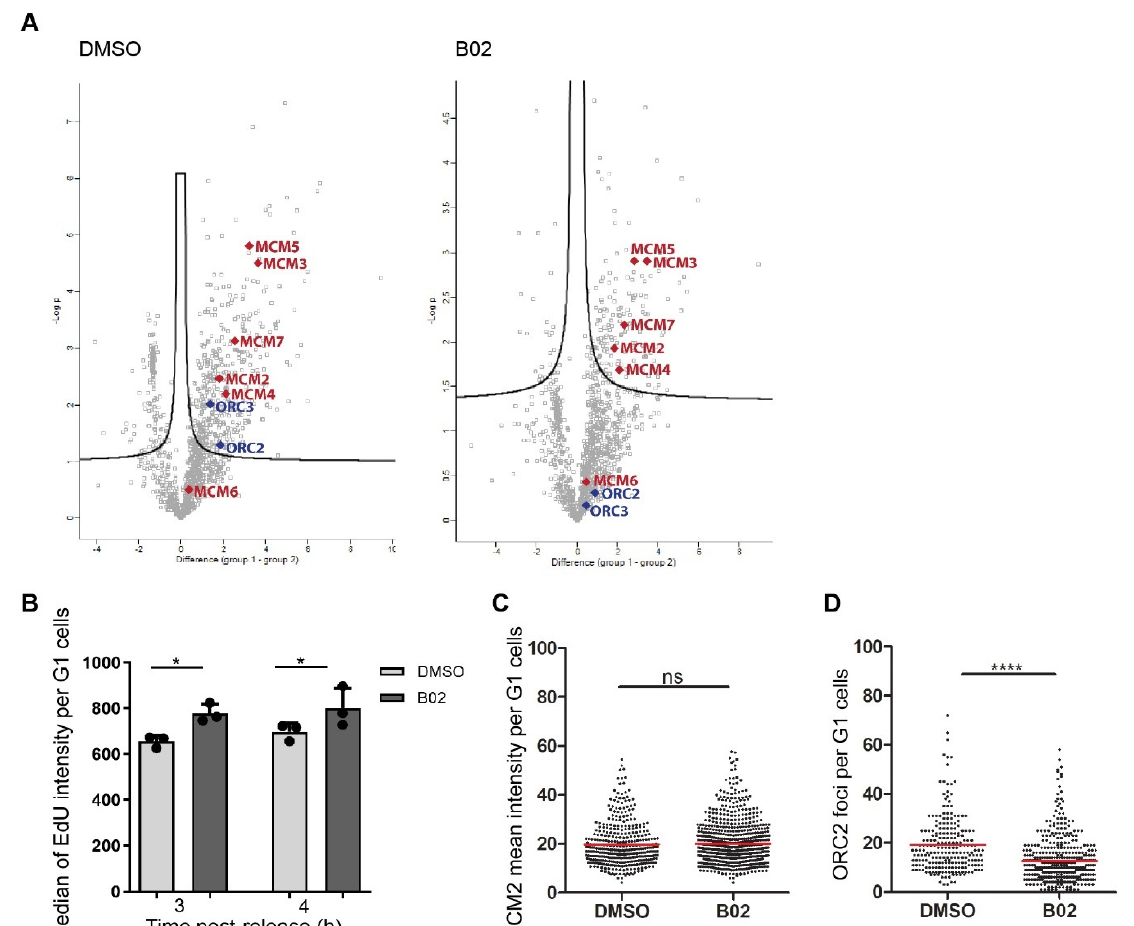
Figure 6. B02 induces DNA synthesis in the early G1 phase. ( A ) Mass-spectrometry screen of proteins associated with R-loops upon B02 treatment. Volcano plots for significantly abundant proteins identified in cells expressing RNH1(D210N)- BioID2-HA chimeric protein. Comparison of cells expressing the fusion protein treated (right panel) or non-treated (left panel) with B02 (20 µM) with the cells that were treated with the vehicle alone (dimethyl sulfoxide, DMSO). Each plot represents the difference in expression of particular proteins between the two conditions plotted against the level of statistical significance (false discovery rate (FDR) 0.2). Significantly abundant proteins are in the upper right corner of the volcano plots. Cell were treated with doxycycline for 24 h, and nocodazole was added for the last 20 h. After release from cell cycle arrest, DMSO or B02 (20 µM), and biotin (20 µM) were added for 4 h. The origin licensing proteins are highlighted on the volcano plots, namely Origin Recognition Complex (ORC, blue) and Minichromosome Maintenance Complex (MCM, red). ( B ) Analysis of 5-Ethynyl-2´-deoxyuridine (EdU) incorporation by flow cytometry. U-2-OS cells were treated with B02 (20 µ M) and EdU (20 µ M) for 3 h or 4 h post-release from nocodazole-induced cell cycle arrest, pre-extracted, fixed, and subjected to flow cytometry analysis. The data on the graph represent median values per condition from 3 independent experiments. ( C ) Image-based quantification of nuclear signal of MCM2 in G1 cells. ( D ) The image-based quantification of number of ORC2 foci in G1 cells. The data shown in ( C – D ) are pooled from 3 independent experiments. The red lines represent the mean values. Statistical significance was determined using Unpaired t test (**** p < 0.0001, * p < 0.05, ns, not